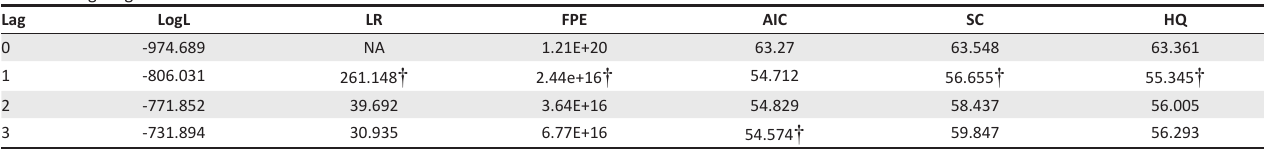
TABLE 3: Lag length selection criteria.